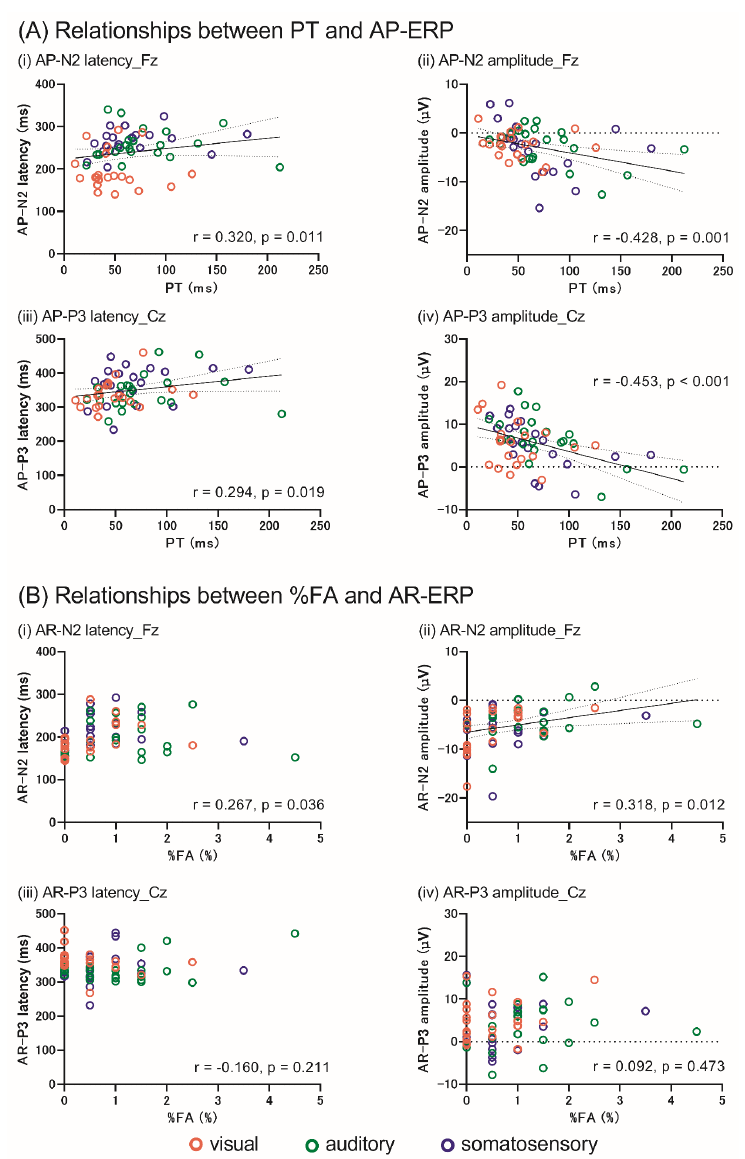
Figure 7. Relationships between the behavioral and neurophysiological data. The orange, green, and blue circles represent the data from the visual, auditory, and somatosensory modalities, respectively. ( A ) Relationship between the PT, AP-N2, and P3. PT was significantly associated with the N2 and P3 latencies and amplitudes (i–iv). ( B ) shows the relationship between %FA and AR-N2 and -P3. There was a significant positive correlation between %FA and AR-N2 amplitude (ii). In contrast, N2 latency (i), P3 latency (iii), and amplitude (iv) showed no significant correlations. The N2 and P3 components indicate the data from Fz and Cz, respectively. AP, action postponing; AR, action restraint; ERP, event-related potential; PT, postponing time; %FA, % false